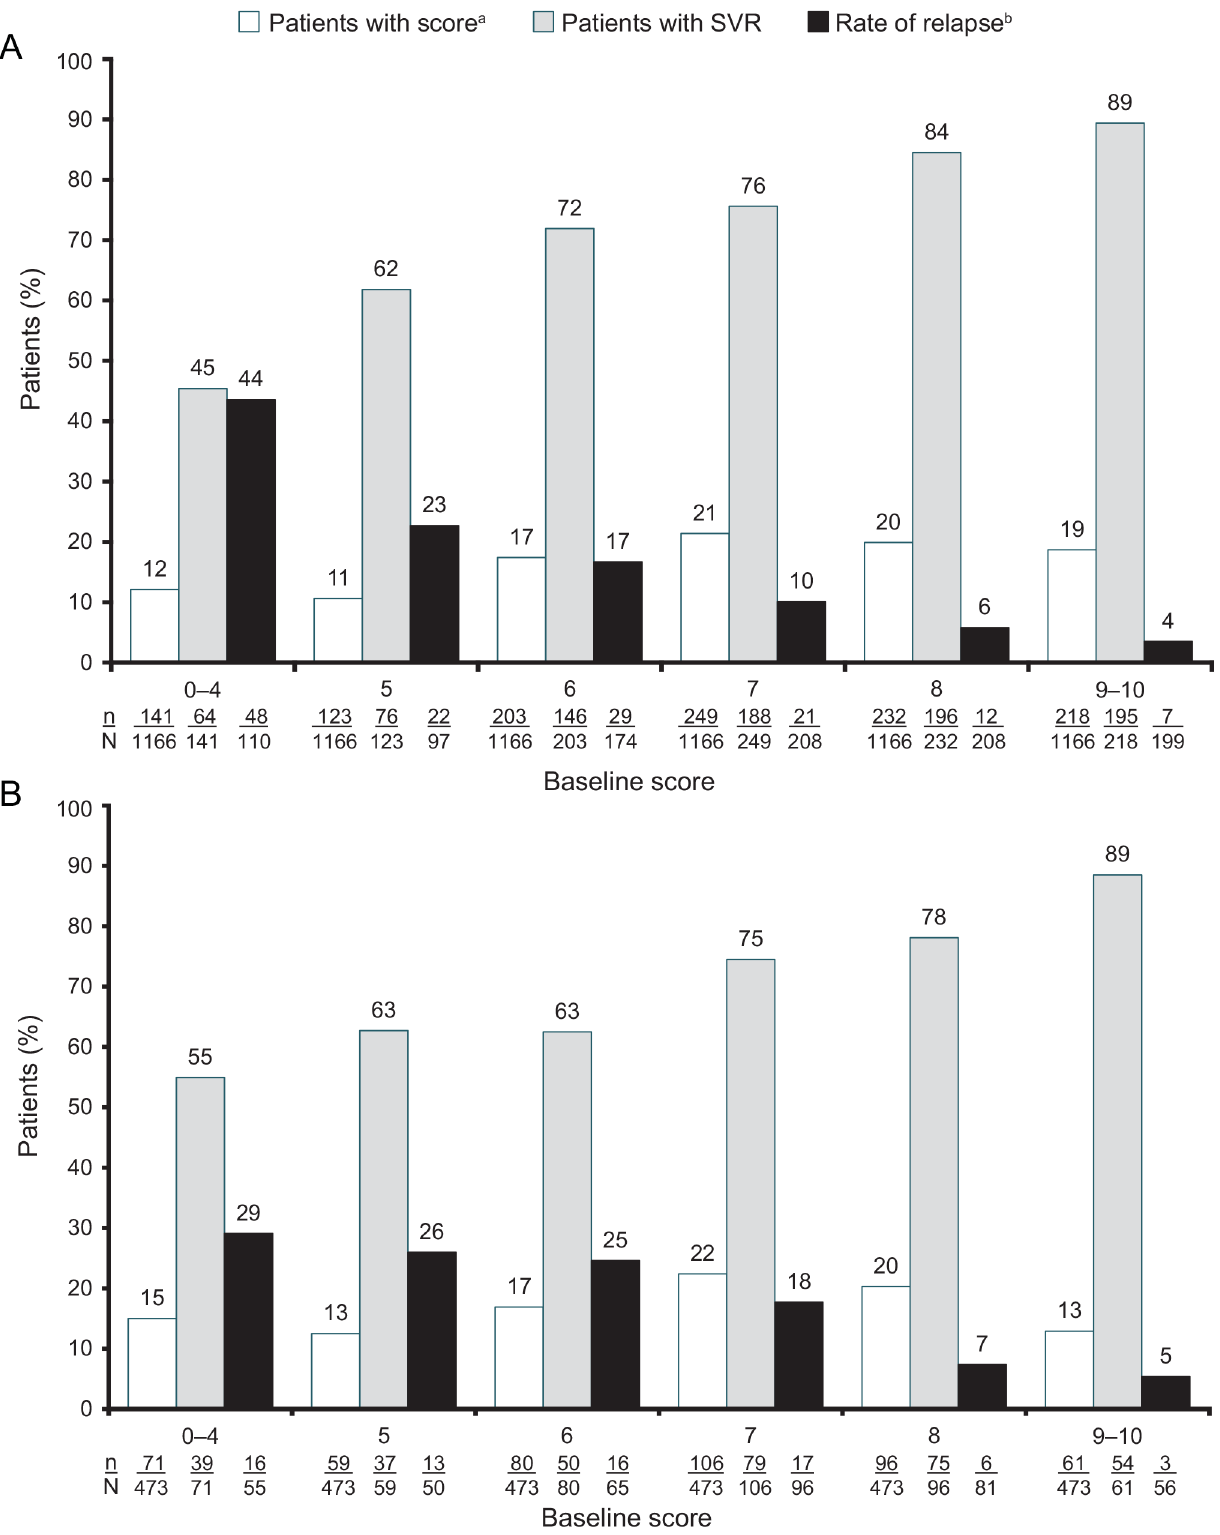
Fig 10. Sustained virologic response and relapse rates in treatment-naive Caucasian patients with HCV genotype 3 by baseline prediction score. A) Development cohort; B) Validation cohort SVR = sustained virologic response 24 weeks post-treatment. a 73 patients did not have a score and were omitted; of these, 46 (63.0%) achieved SVR. b Patients with end-of-treatment response and sufficient follow-up.